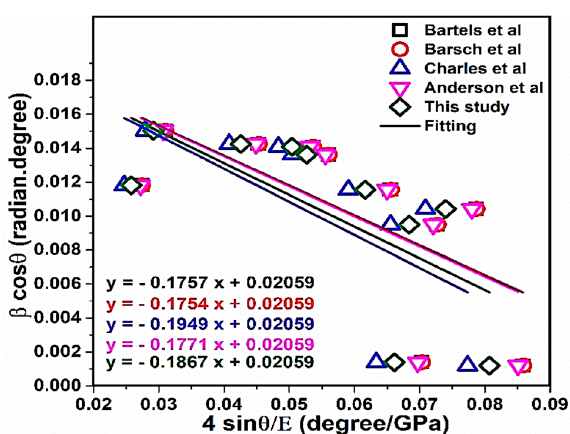
Figure 9. Modified (William–Hall, W–H) uniform stress deformation model (USDM) plot of NaCl. Table 6. Values derived from the mechanical properties related to NaCl. Mechanical Properties Study